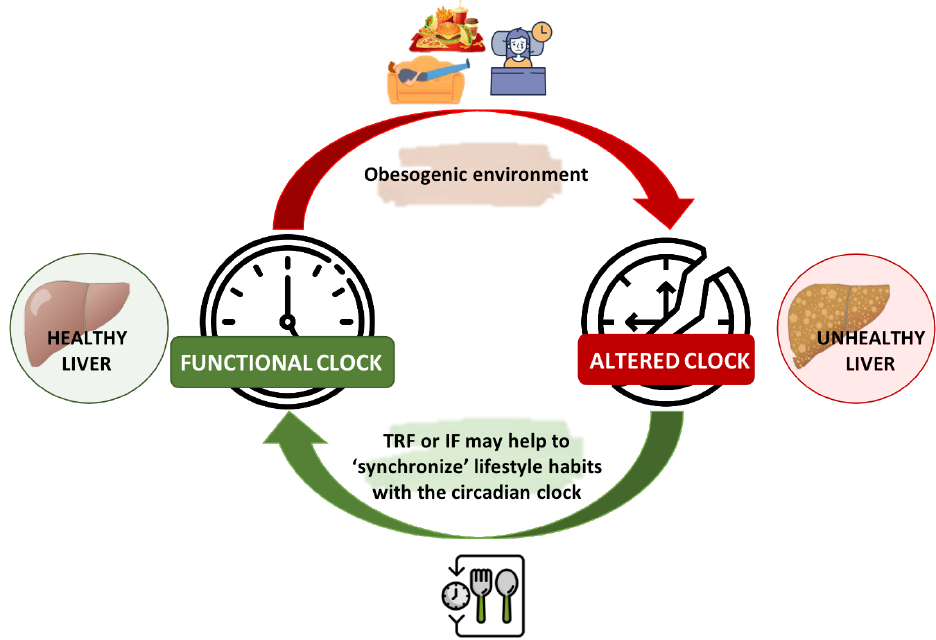
Figure 2. Chrononutrition in the alignment of the liver’s circadian rhythm. Current